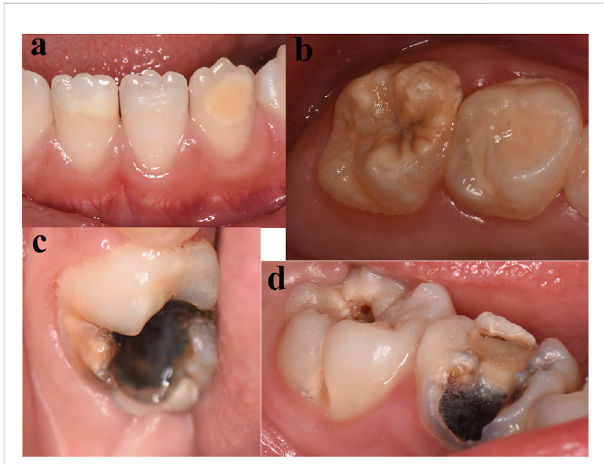
FIGURE 3 Phenotype of MIH. The majority of hypomineralized permanent teeth exhibited white (A) and yellow (B) demarcated lesions. (C) Atypical carious lesions associated with demarcated opacities in the fi rst permanent molar. (D) Typical caries in the fi rst permanent molars and atypical restorations in the primary